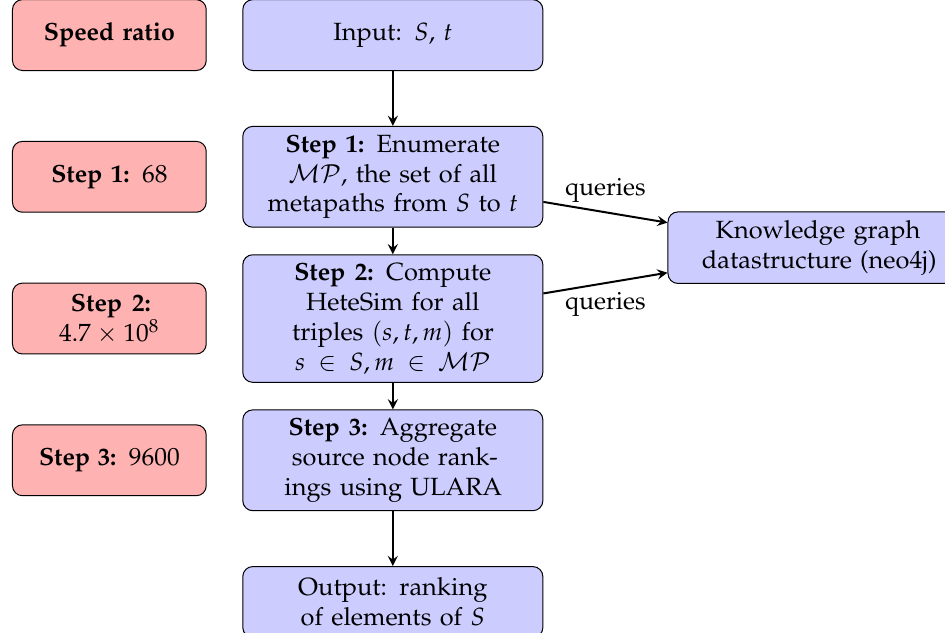
Figure 2. Overview of SemNet version 1 HeteSim implementation. Speed ratio is computed as ( SemNet 1 time ) / ( SemNet 2 time ) and is given for source node insulin and target node Alzheimer’s disease. In SemNet 2, the approximate mean HeteSim algorithm is used with approximation parame- ters (cid:101) = 0.1 and r =